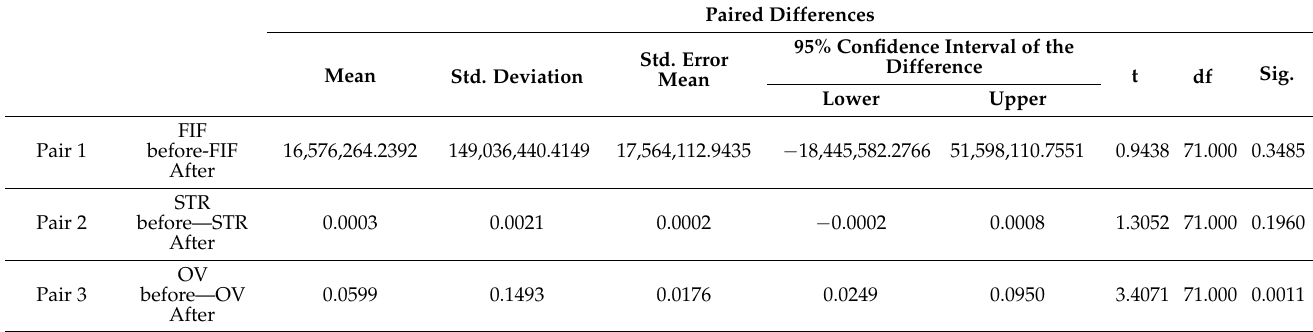
Table 5. Paired Sample t -Test.